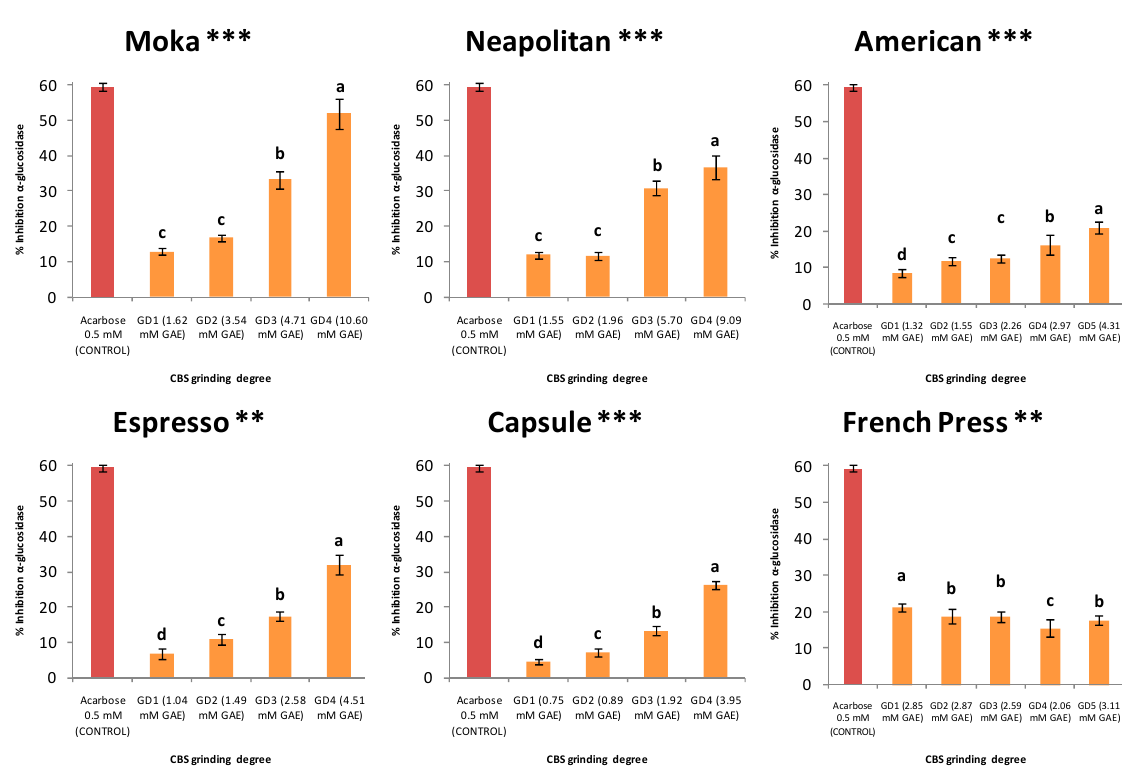
Figure 2. α -Glucosidase inhibition by the beverages produced via the six techniques at various CBS GDs related to the total phenolic content expressed in mM GAE (gallic acid equivalents); ANOVA among GDs for each technique. Acarbose at 0.5 mM (IC 50 ) served as a control. Different letters indicate significant differences among the GDs at p < 0.05. Significance: ** p < 0.01; *** p < 0.001.